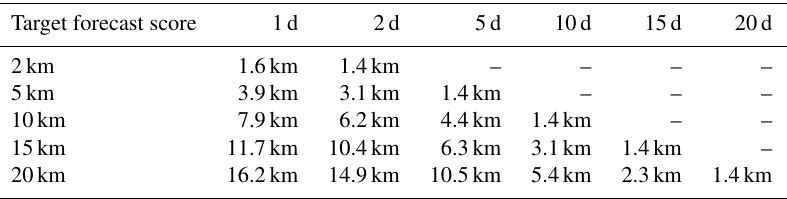
Table 4. Initial location accuracy required (location score) to obtain the target final location accuracy (location score, left column) with a 95% confidence for different forecast time lags between 1d and